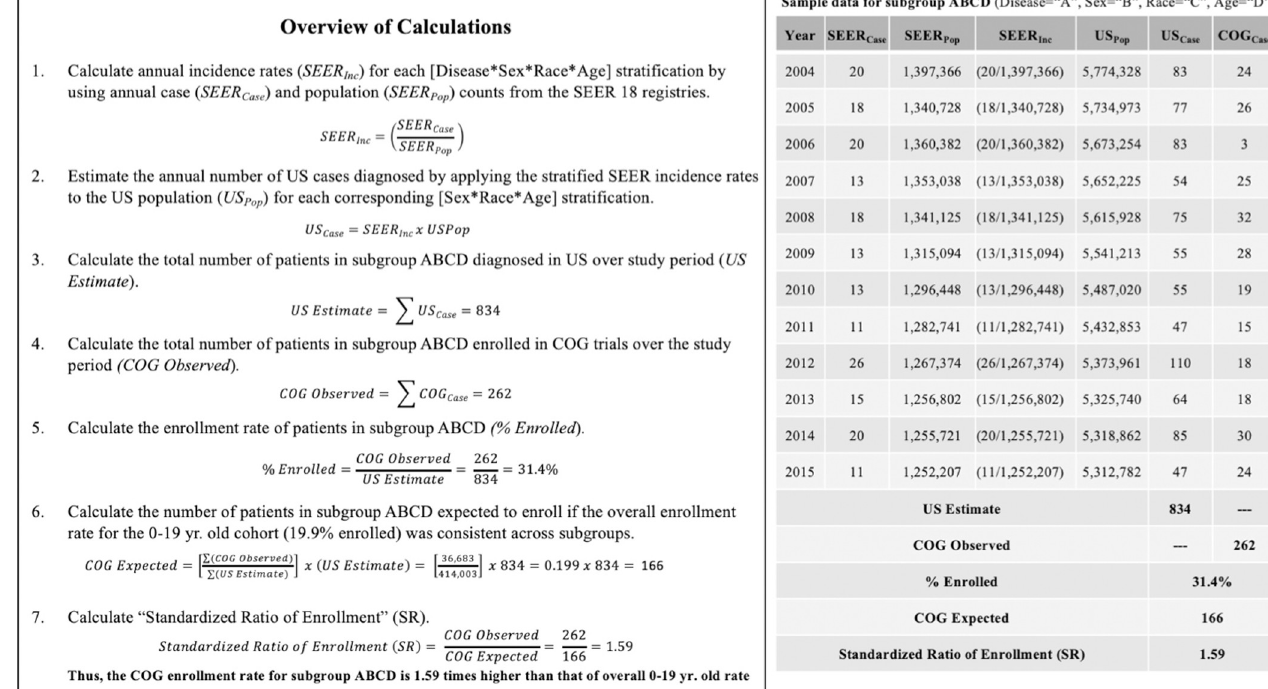
Fig 1. Calculation of standardized ratio of enrollment (SR) for COG